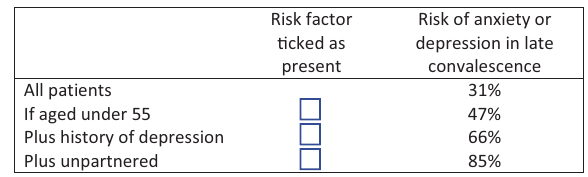
FIGURE 3 | Cumulative risk of anxiety or depression for three key risk